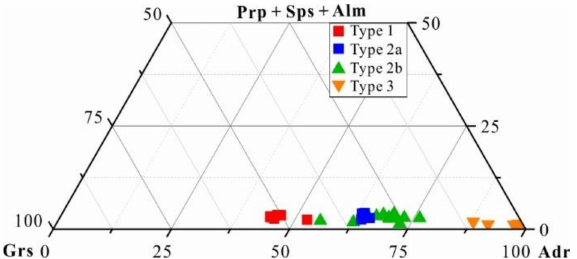
Figure 7. The ternary classification diagram for garnets (almandine, pyrope and spessartine in Y sites). Abbreviations: Grs, grossular; Adr, andradite; Prp, pyrope; Sps, spessartine; Alm, almandine (on the basis of [58]).